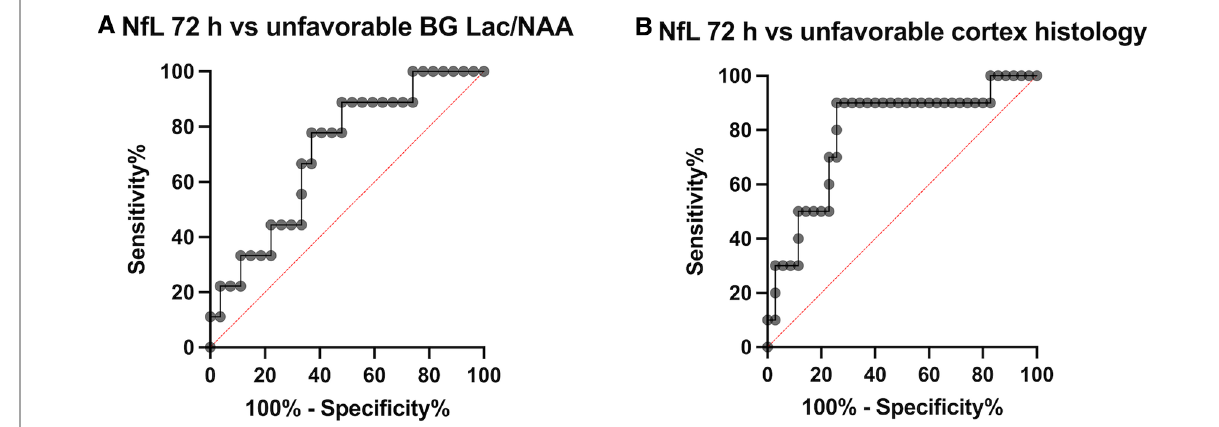
FIGURE 5 Receiver operating characteristic (ROC) curves, ( A ) comparing NfL-72 h with an unfavourable imaging outcome with basal ganglia Lac/NAA ratio in the worst quartile and ( B ) NfL-72 h with unfavourable outcome with cortex histopathology in the worst